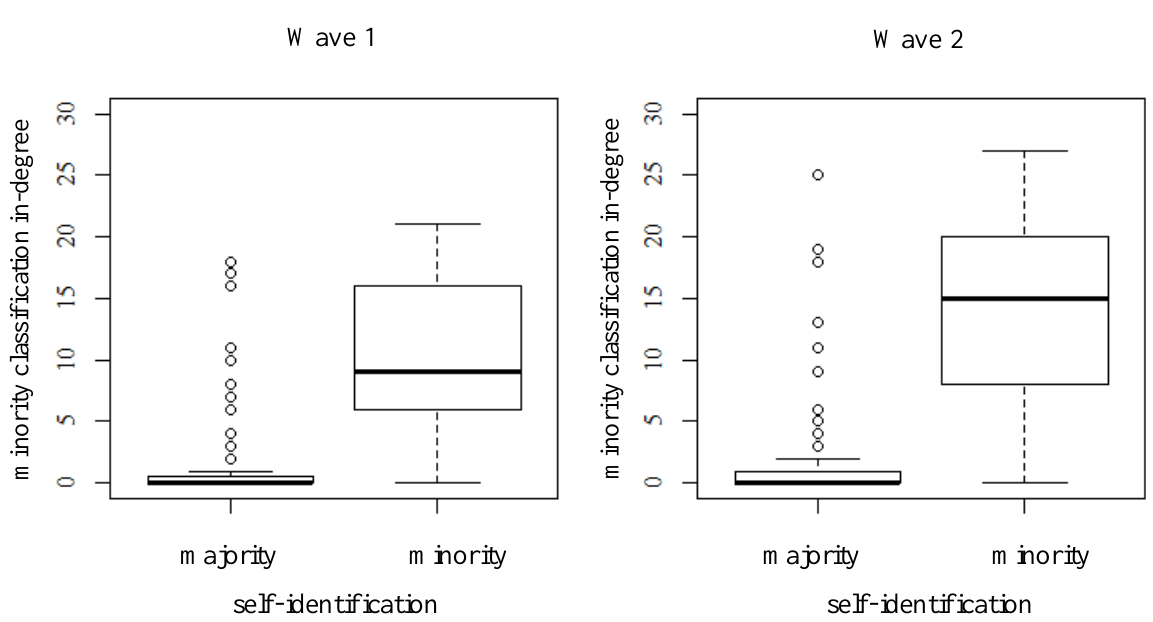
Figure 1: Minority self-identifications and the number of incoming minority classifications received in wave 1 and wave